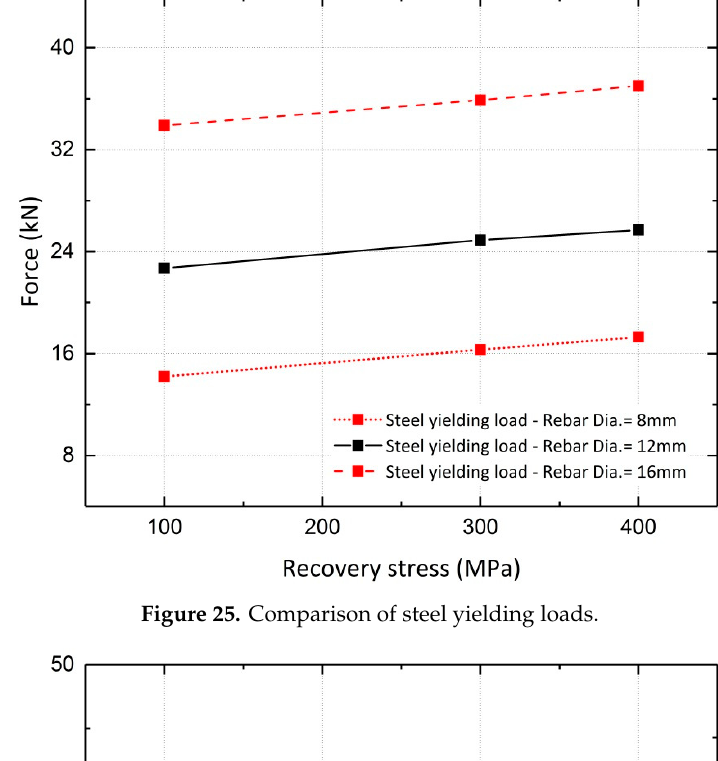
Figure 24. Comparison of cracking loads.